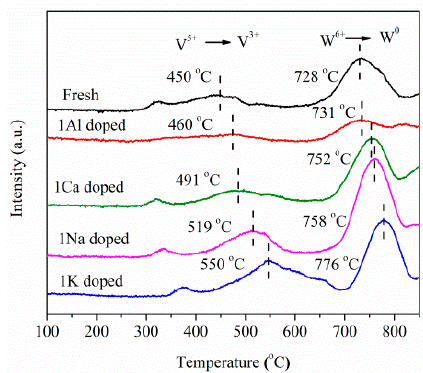
Figure 7. H 2 -temperature programmed reduction (TPR) profiles of fresh (1V-5W/Ti) and 1 M doped catalysts (M = Al, Ca, Na, and K) .